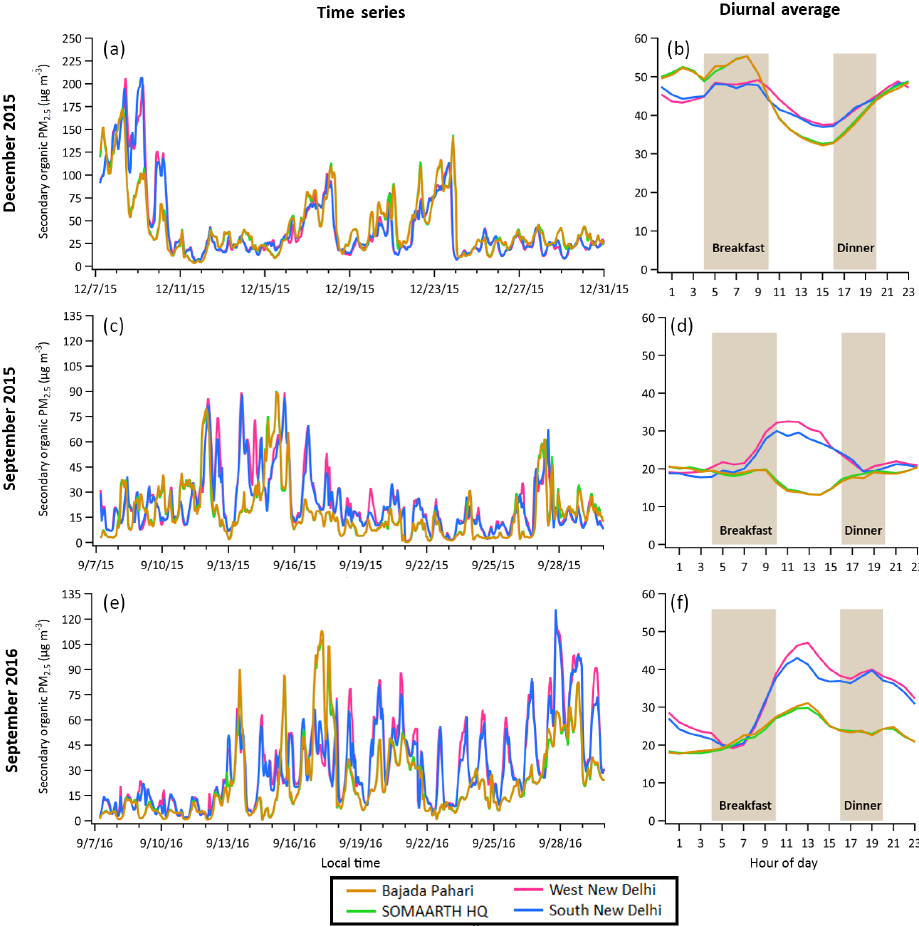
Figure 10. Predicted secondary organic PM 2 . 5 (a, c, e) and average diurnal cycle (b, d, f) for 20–31 December 2015 (a, b) , 7–30 Septem- ber 2015 (c, d) , and 20–30 September 2016 (e, f) . Bajada Pahari is shown in yellow, SOMAARTH HQ in green, West New Delhi in pink, and South New Delhi in blue. Diurnal profiles were averaged over simulation durations (Table 7). Computations were carried out at 4km resolution. Statistics are shown in Table